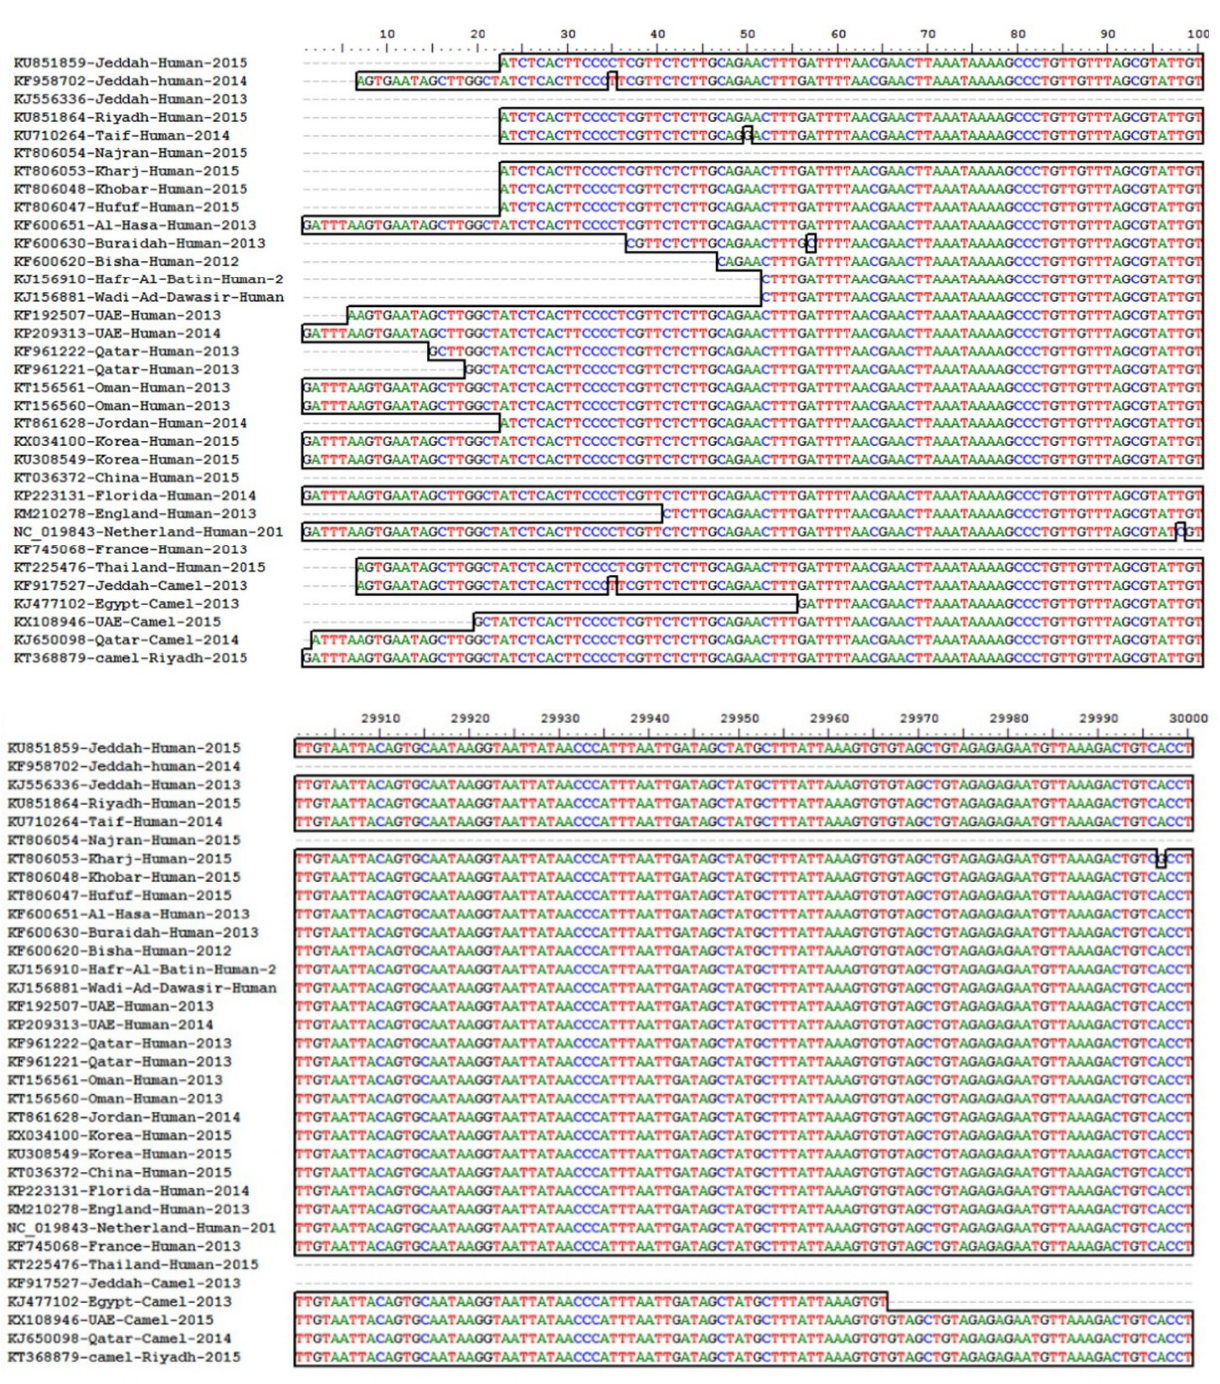
Figure 1. Multiple sequence alignment of selected MERS-CoVs (Nucleotide sequences start. 1 . . . . . . 300,000 bp. Due to space limitations, we have selected the conserved regions only to display in the figure).